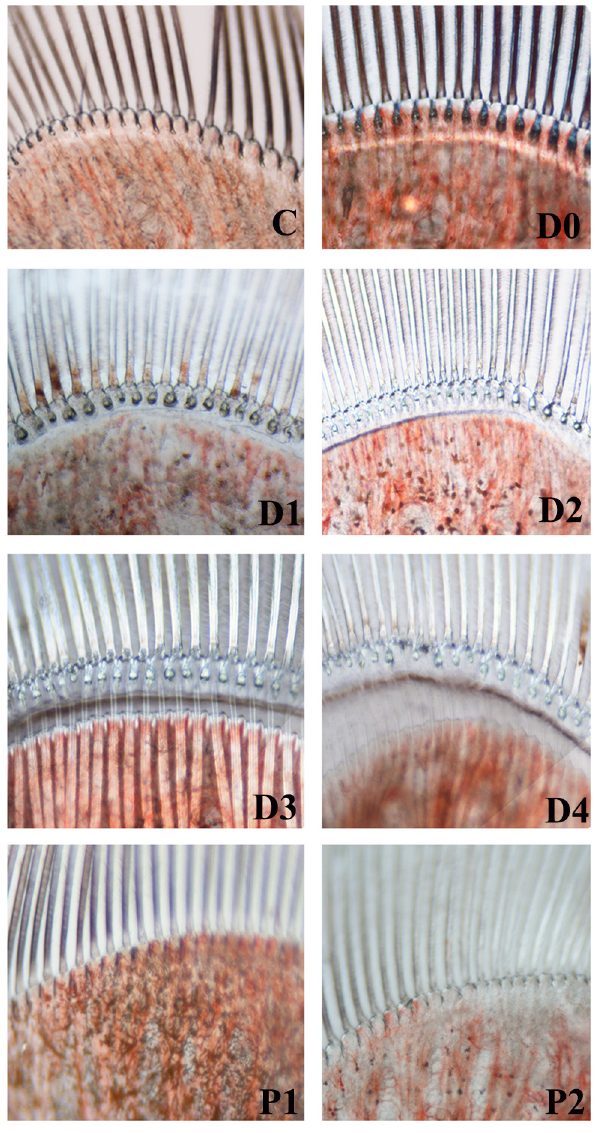
Fig 1. Morphological changes of shrimp uropods during molting stages under a light microscope (400 × magnification). Observed physical characteristics of each stage were as follows: 1) Inter-molt stage (C stage): mature setal cones and fully-spread epidermis. 2) Pre-molt stage (D stage): D0, a clear margin of epidermal tissue at the base of the setal cones. D1, a clear, narrow zone between the setal cones and the epidermis. D2, a wider clear zone and a wavy edge of epidermis. D3, a wider clear zone, highly wavy edge of epidermis, and a thin, white layer at the edge of the epidermis. D4, a noticeably wider clear zone, serrated edges of epidermis, a light-reflecting white layer at the edge of the epidermis, and parallel-band edepidermis. 3) Post-molt stage (P stage): P1, soft and delicate setae, absence of setal cones. P2, presence of young setal